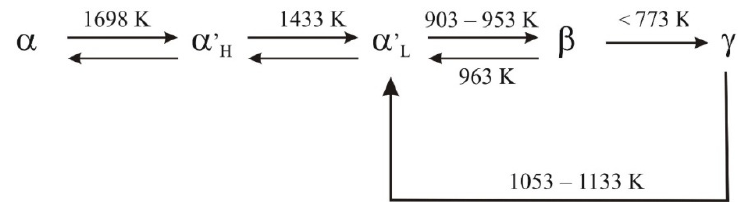
Figure 1. Polymorphic transitions of Ca 2 [SiO 4 ] [4].